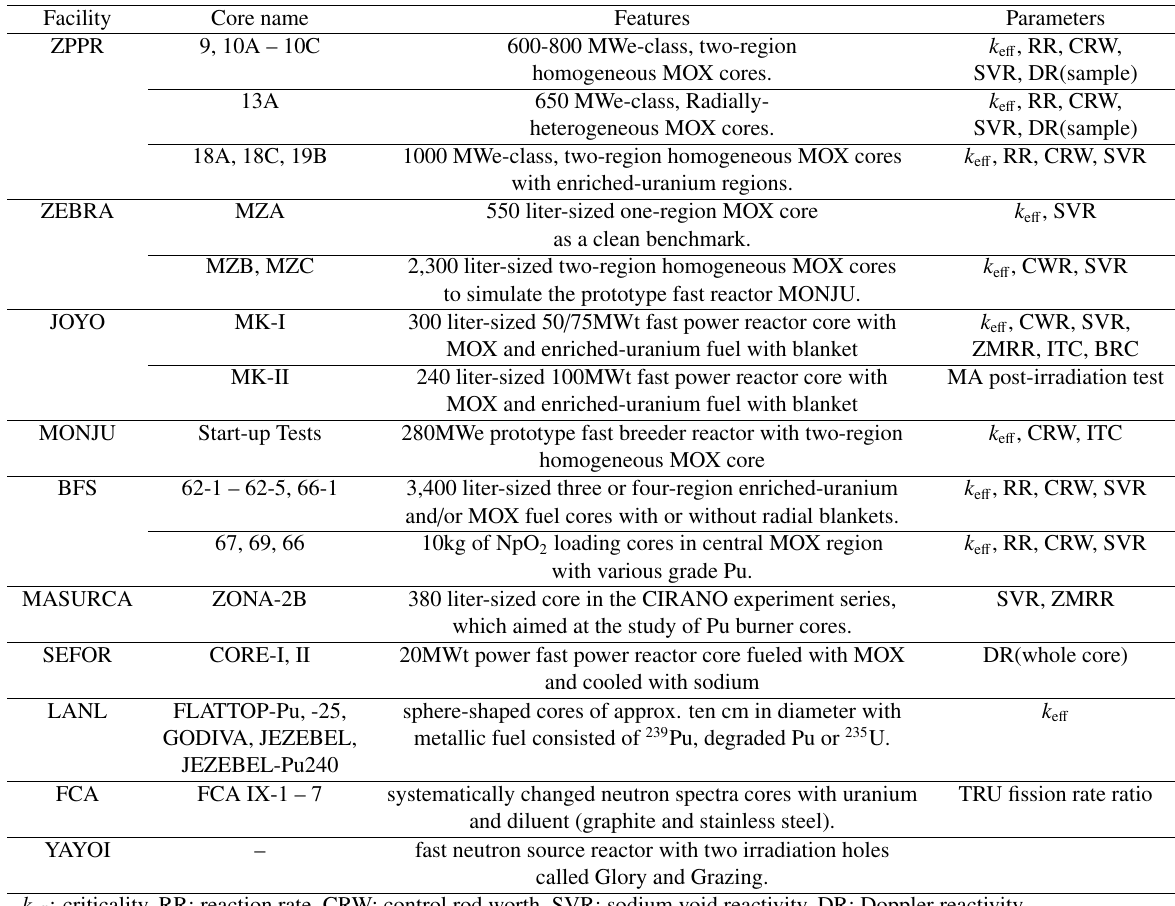
Table 2. Integral experimental data used for